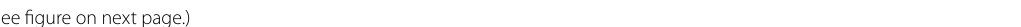
80 km, 0 km, and 80 km, b X 0 km, 30 km, and 60 km (locations shown in = − = 2.0. Other = ×